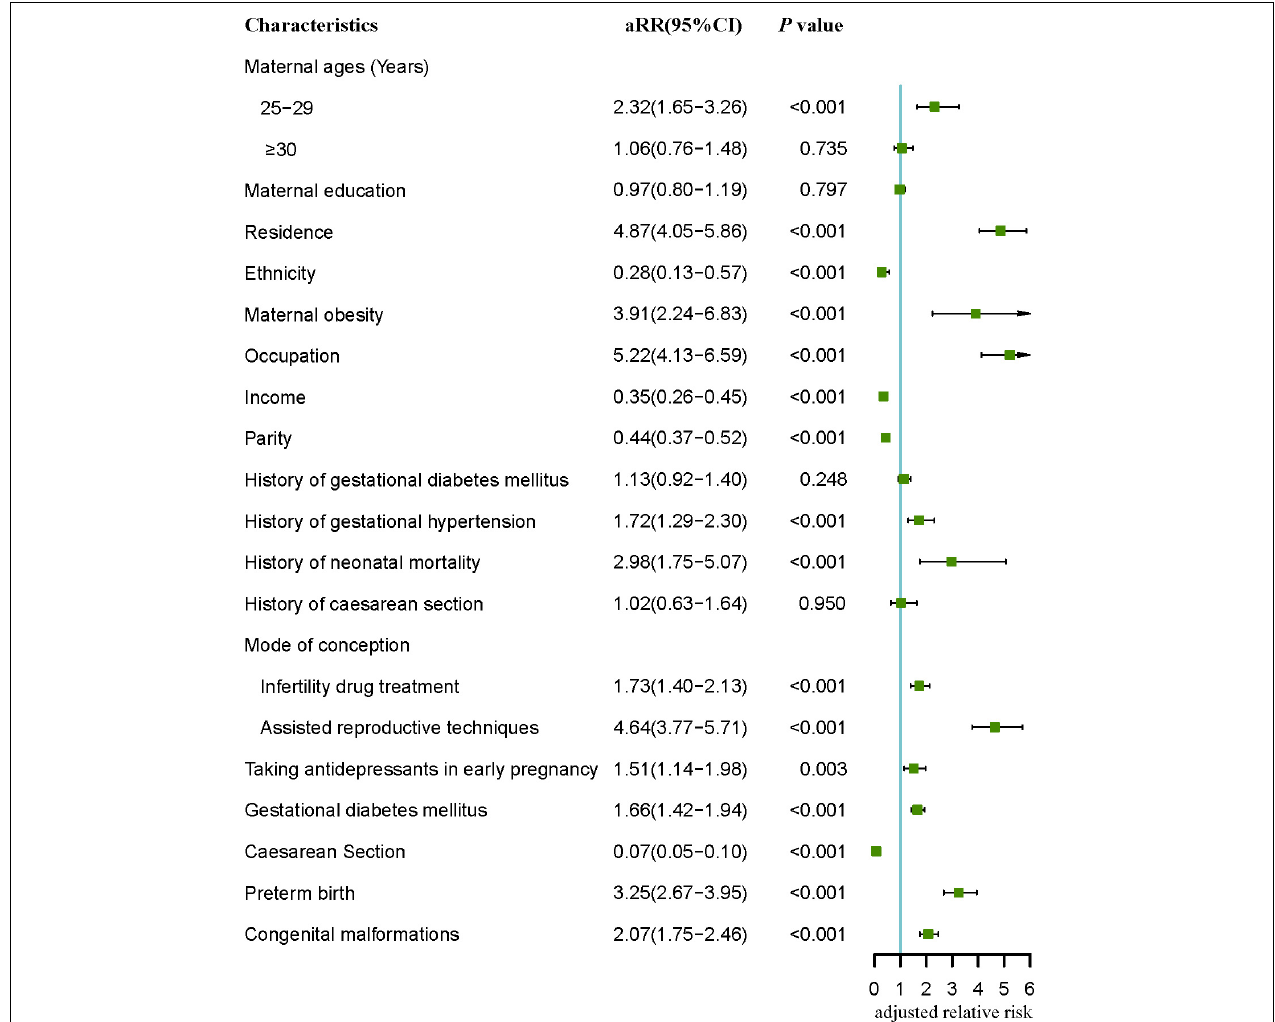
FIGURE 2 | Multivariate analysis of significant ( p < 0.05) risk factors in Tables 1 – 4 . aRR, adjusted relative